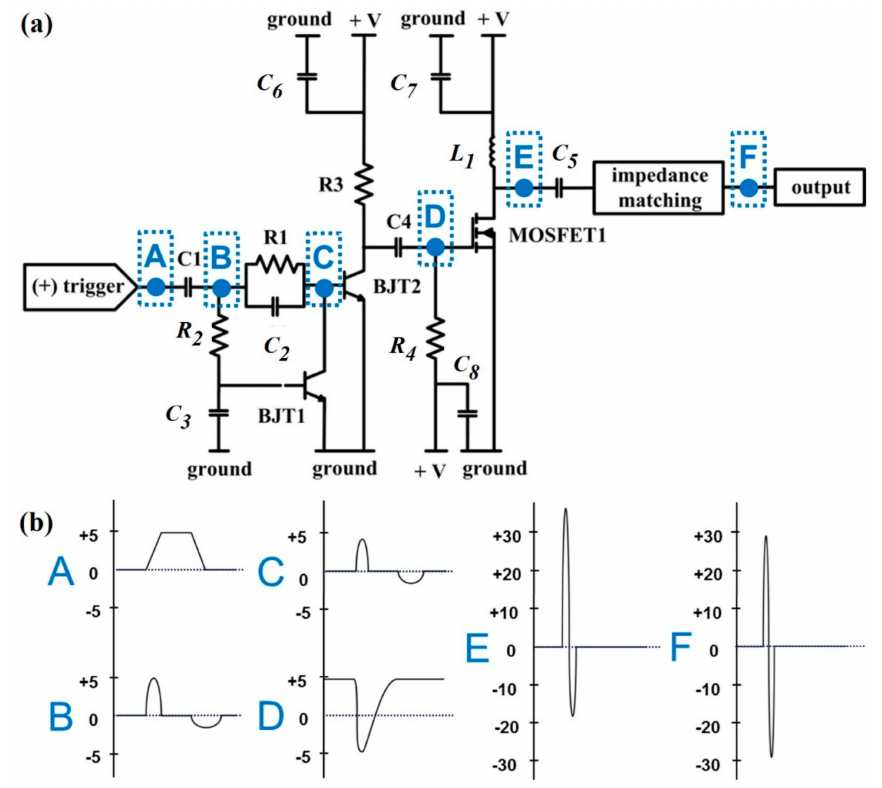
Figure 1. Proposed pulse generator: ( a ) Schematics of pulse generator; ( b ) output wave forms at the blue dotted position from A to F. The unit of the y -axis is